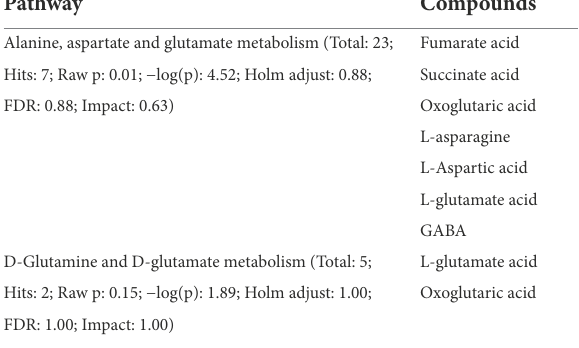
TABLE 4 Pathways enriched in microbiota-related metabolites. Pathway